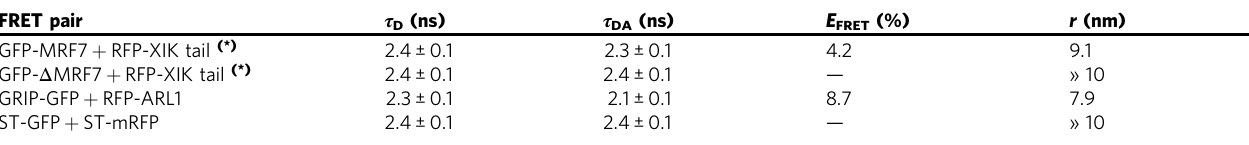
Table 1 Average lifetime values, FRET ef fi ciencies and estimated intermolecular distance for the FRET pairs tested. FRET pair τ D (ns) GFP-MRF7 + RFP-XIK tail